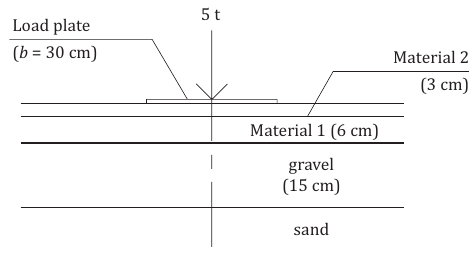
Figure 4. Scheme of the road structure